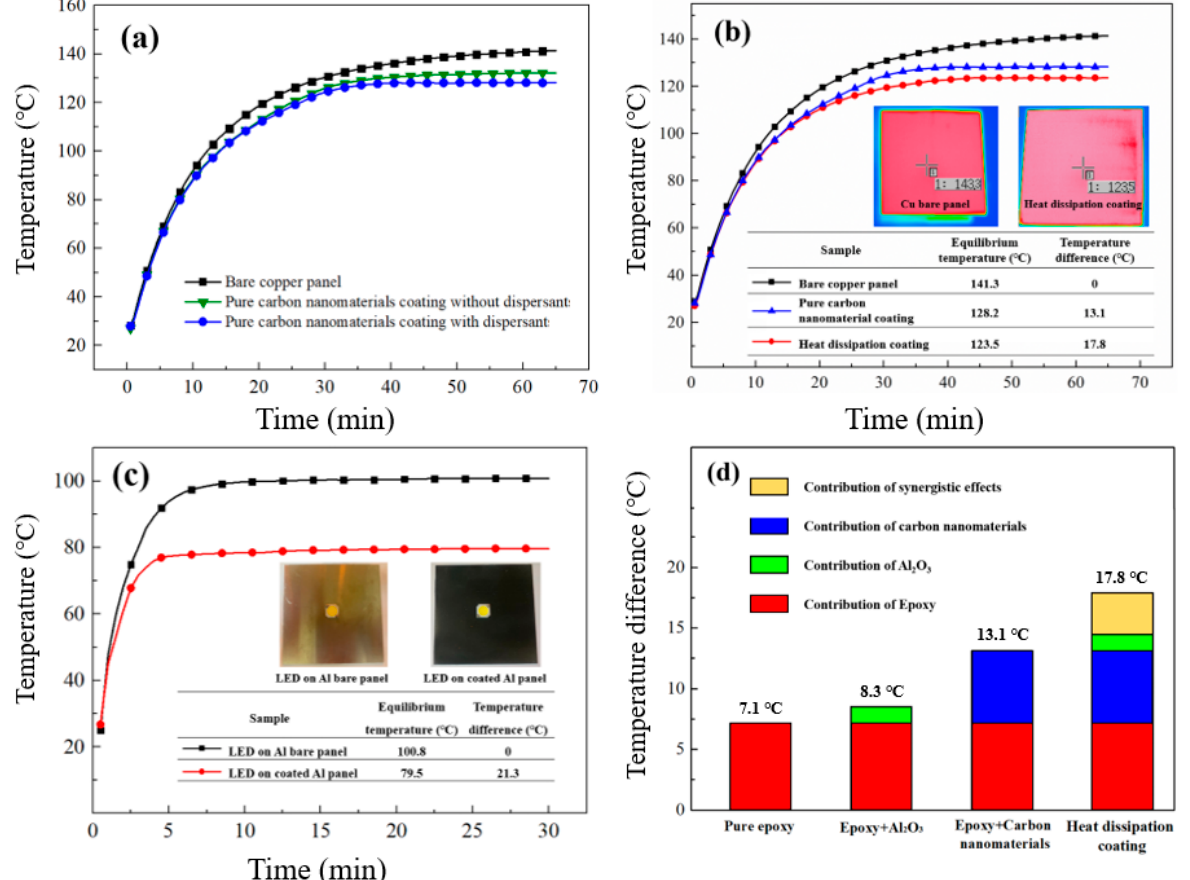
Figure 9. Temperature profile versus operation time curves of: ( a ) A bare copper panel and coating with or without dispersion; ( b ) a bare copper panel and different loadings of graphene coatings; ( c ) the 15 W LED bulb dissipating test. ( d ) Synergistic effect on the enhancement of heat-dissipating performance from various fillers.